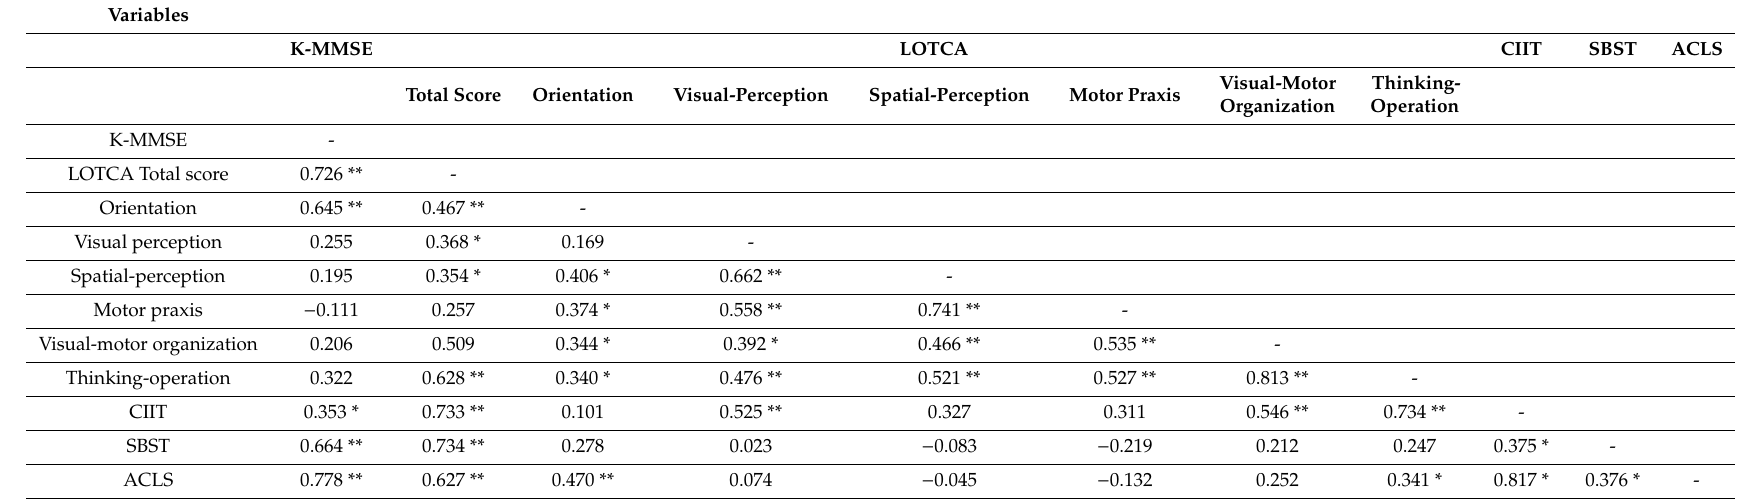
Table 3. Correlations among basic neurological cognitive function, social cognition, and Allen cognitive